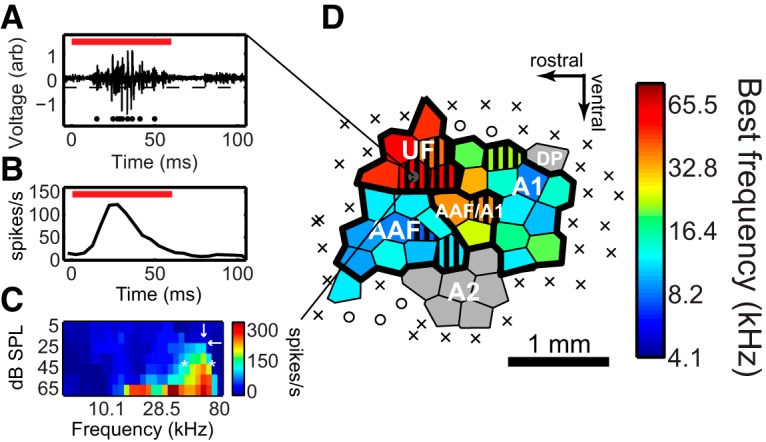
Multiunit electrophysiology methods. A, Voltage trace of a sound-evoked multiunit response. The red bar indicates tone playback (60 ms), and the dashed line represents the user-defined spiking threshold. B, Sample peristimulus time histogram of sound-evoked multiunit spiking responses. The red bar indicates tone playback. C, Frequency response area for a sample multiunit. Spiking responses are indicated with hot colors representing a greater evoked response; responses at seven sound amplitudes (5–65 dB SPL, in 10 dB steps) and 30 frequencies (4–80 kHz log spaced) are shown. Downward white arrow indicates BF; leftward white arrow indicates threshold; white asterisks indicate lower and upper boundaries of the bandwidth at 20 dB above threshold. D, A sample Voronoi tessellation representing the tonotopic map of an animal. Hot colors represent higher BFs. Auditory regions are labeled according to region delineations defined in the study by Stiebler et al. (1997). Core AC areas (UF, AAF, AAF/A1, and A1) are outlined in a thick black line. Non-core auditory areas (A2, DP) are in gray. Hashed sites respond to USVs. X indicates areas that are not tone responsive.